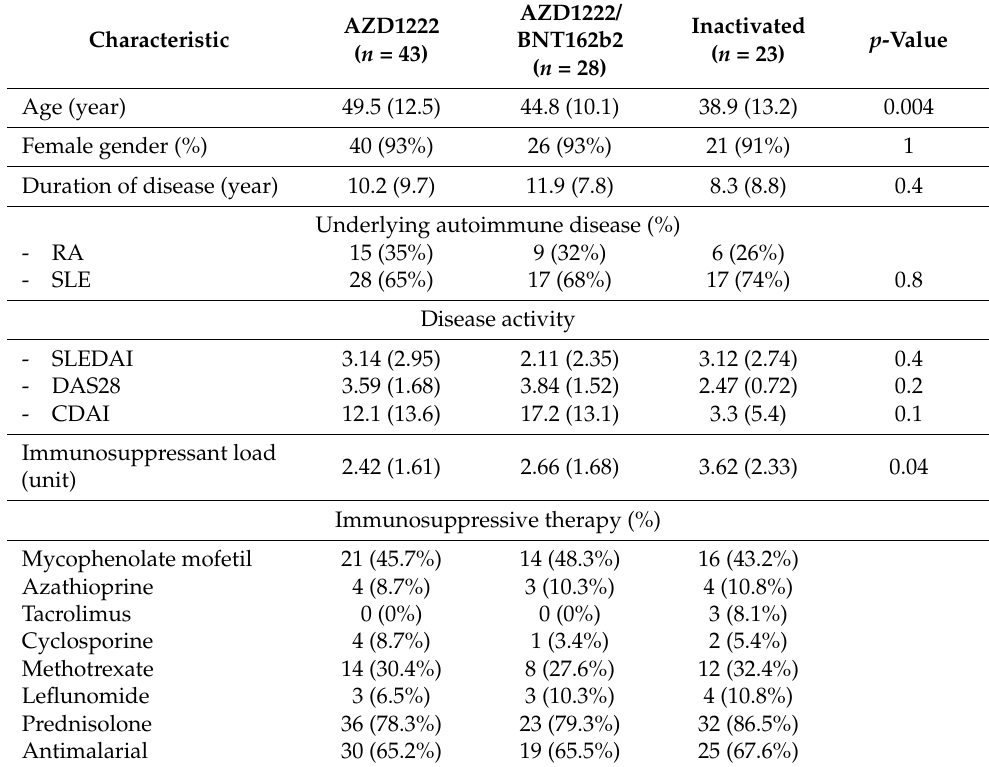
Table 2. Baseline characteristics stratified by vaccine groups.